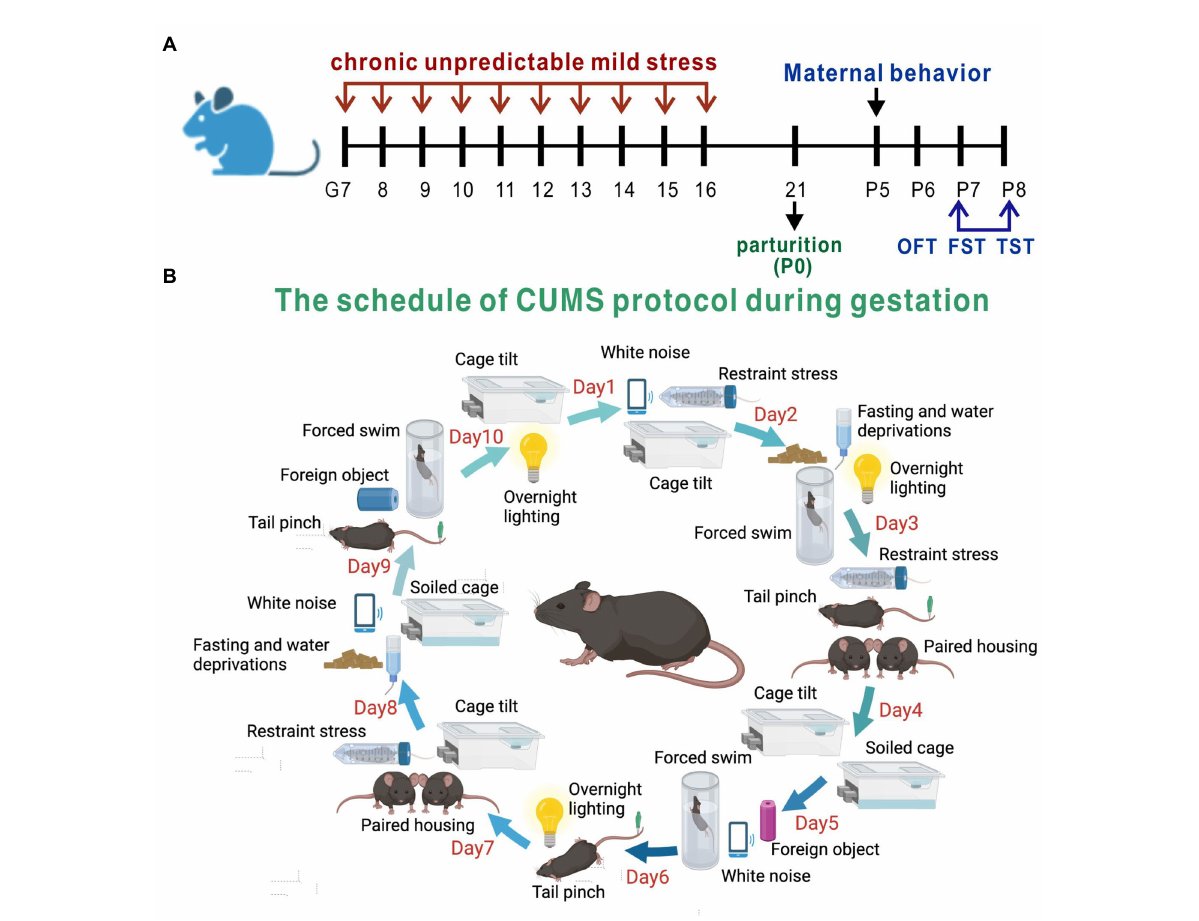
FIGURE 1 Experimental design and the method of PPD model establishment. (A) The timeline of model establishment and behavioral tests. (B) The schedule of CUMS protocol during